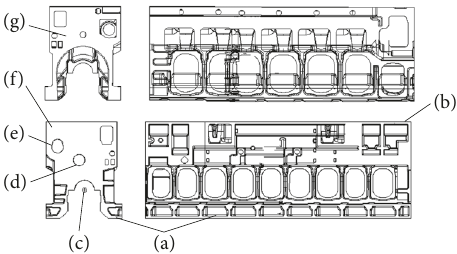
Figure 1: Structure of L type internal combustion engine block. (a) The bottom surface; (b) cylinder hole surface; (c) crankshaft; (d) idler wheel hole; (e) camshaft hole; (f) flywheel surface; (g) pump cover